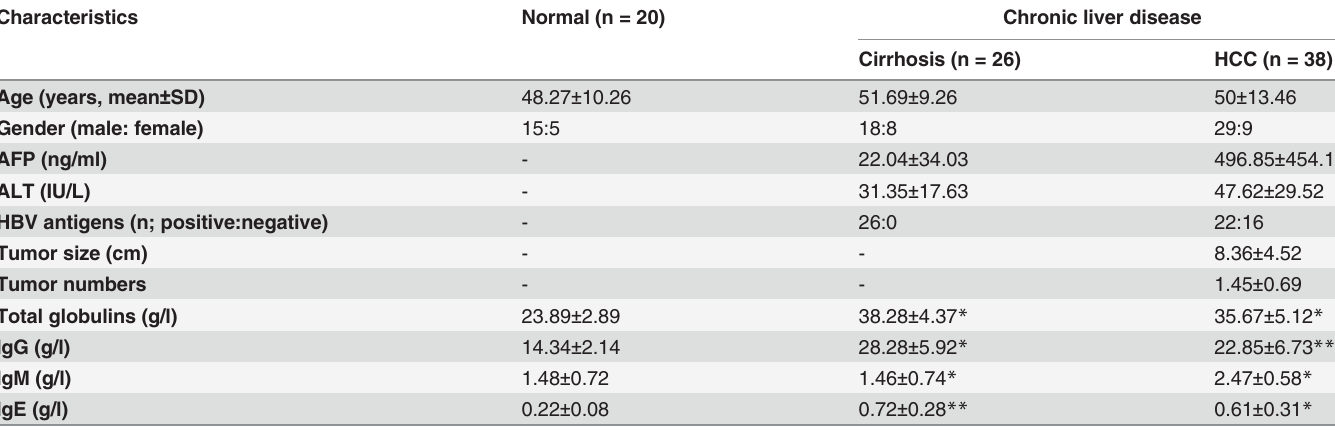
Table 1. Clinical and biochemical characteristics of patients with chronic liver